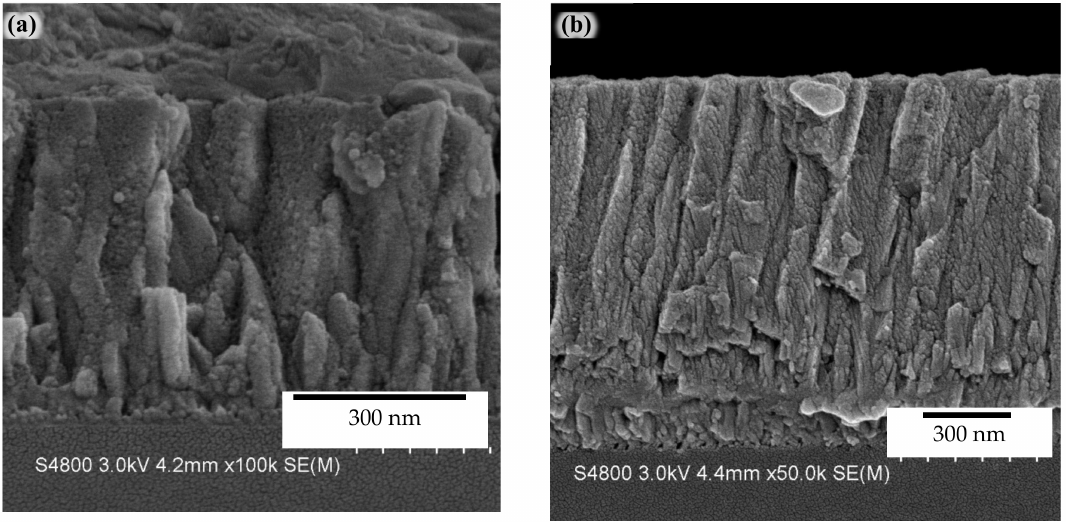
Figure2. Cross-sectionalSEmicrographsofTiNdepositedby( a )HIPIMSand( b